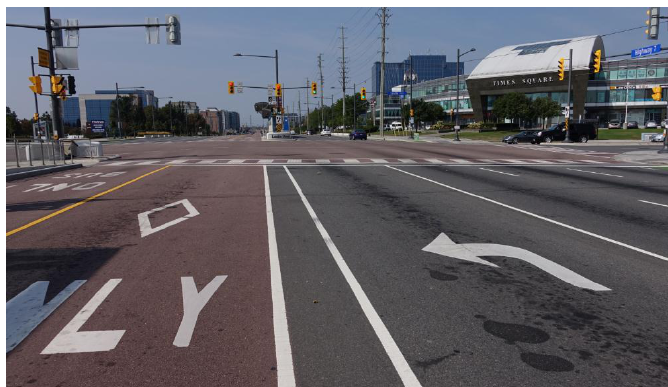
Figure 8. Monitored discoloration caused by oil drips and formation of oil streaks.